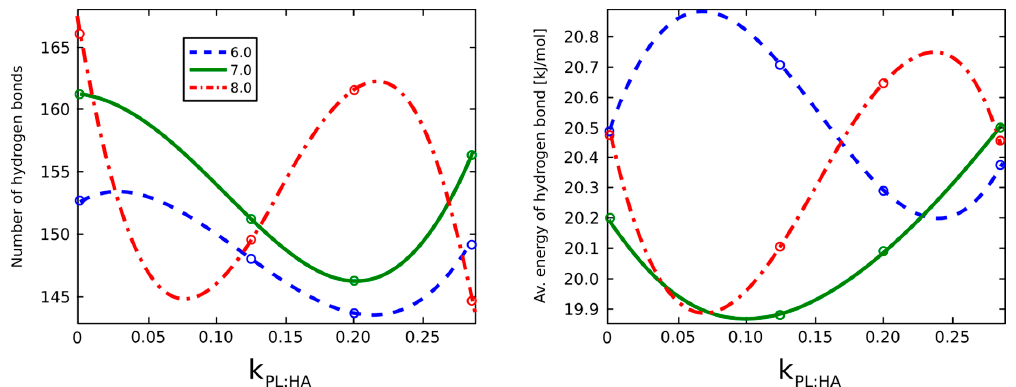
Figure 15. The number of hydrogen bonds ( Left ) and its average energy ( Right ) in HA as dependent on pH and PL concentration. The legend indicates pH values.